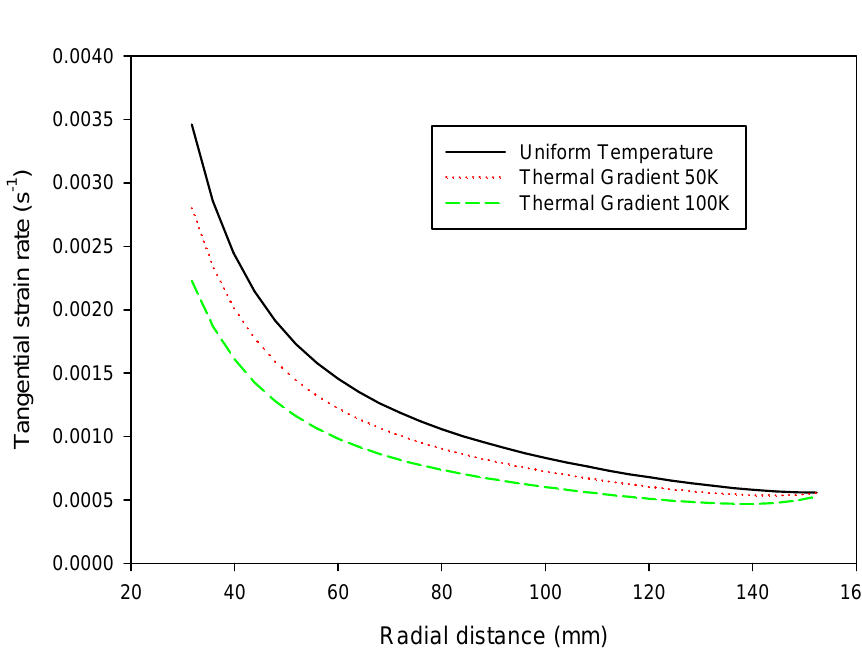
Figure 4. Variation of tangential strain rate along the radial distance wiyh composite disc with/without thermal